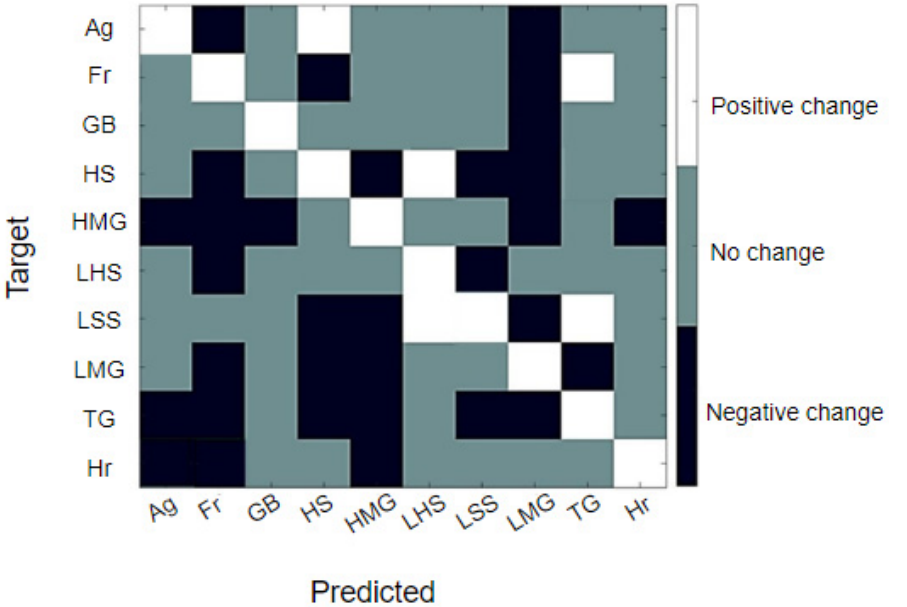
Figure 9. A detailed comparison of two classification methods, the matrix is the result of subtracting the confusion matrix of the SSLES from the SSL. The white colour represents an increase in the cell’s value, black indicates a decrease, and if the value was unchanged, it was coloured cyan.